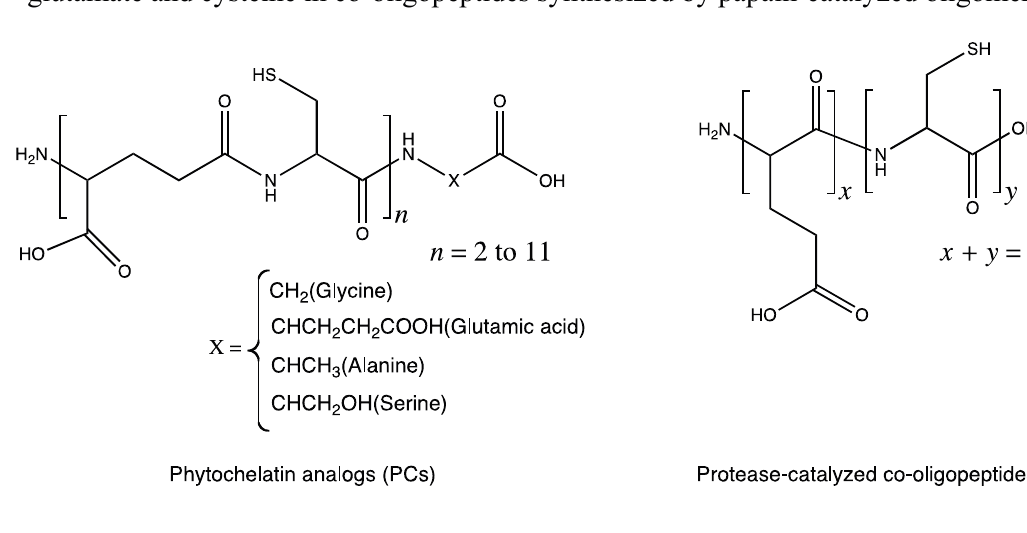
Figure 5. γ -Link between glutamate and cysteine residues in phytochelatin and α -link between glutamate and cysteine in co-oligopeptides synthesized by papain-catalyzed oligomerization.